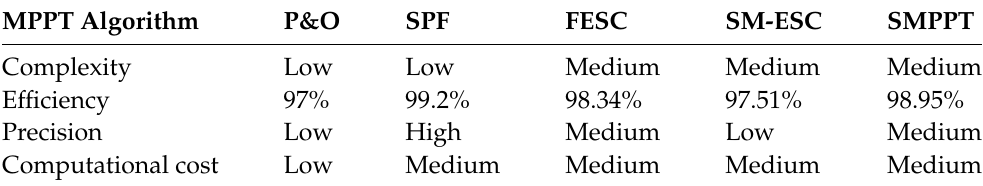
Table 6. Comparison of MPPT